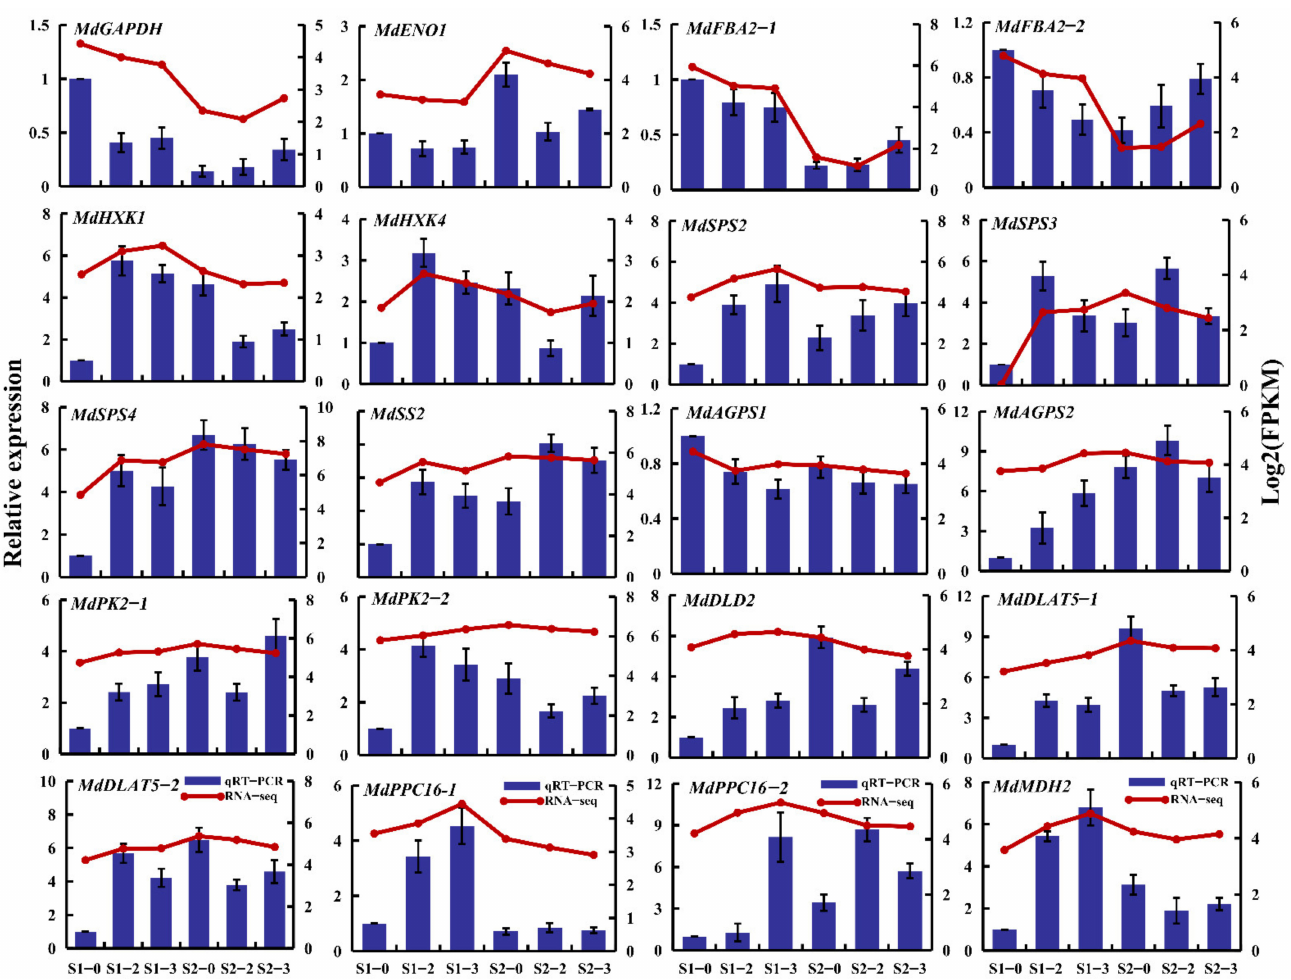
Figure 8. The qRT–PCR analysis of selected DEG genes in apple fruit under different nitrogen levels. Error bars represent standard errors of the relative expression levels mean values by qRT–PCR ( n = 3) (left y–axis). Broken lines represent transcript levels (log2 FPKM) according to RNA–Seq (right